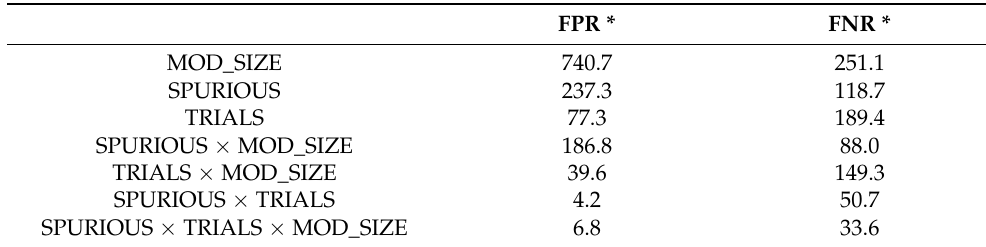
Table 2. Results of the three-way ANOVA (F-value) performed on the performance parameters FPR and FNR, evaluated after estimating and validating PDC